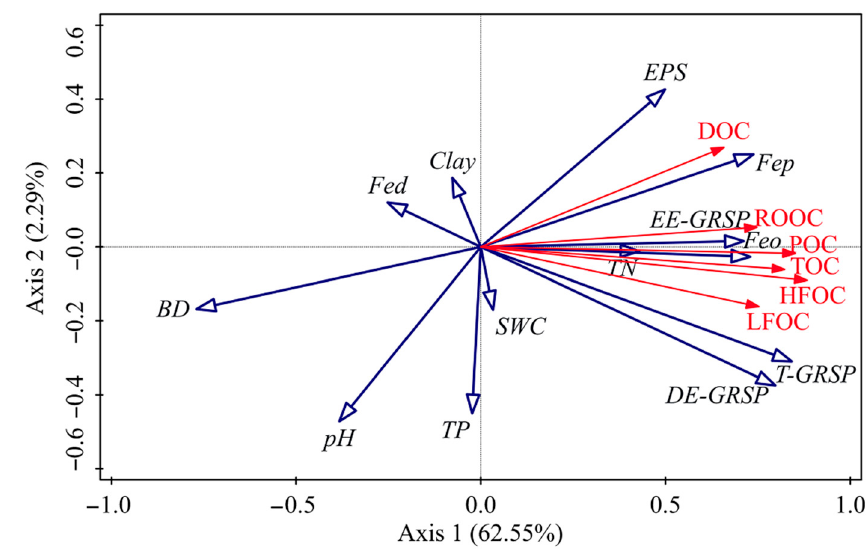
Figure 7. Redundancy analysis of the soil carbon indices and soil properties for five vegetation types.